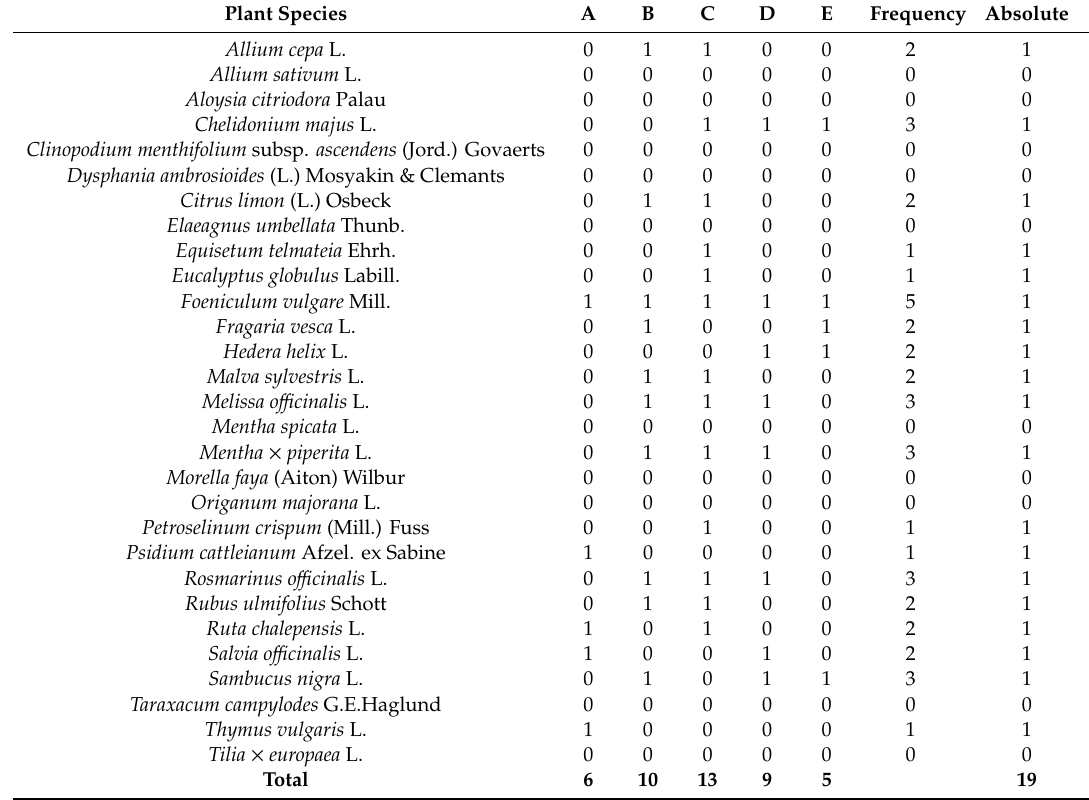
Table A2. Presence and absence of the studied species in the context of previous literature. A [79]; B [45]; C [22]; D [23]; E [24]. Plant Species A B C Allium cepa